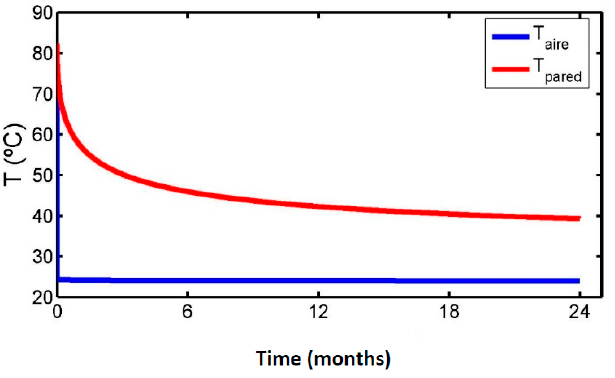
Figure 1. Temperature evolution.